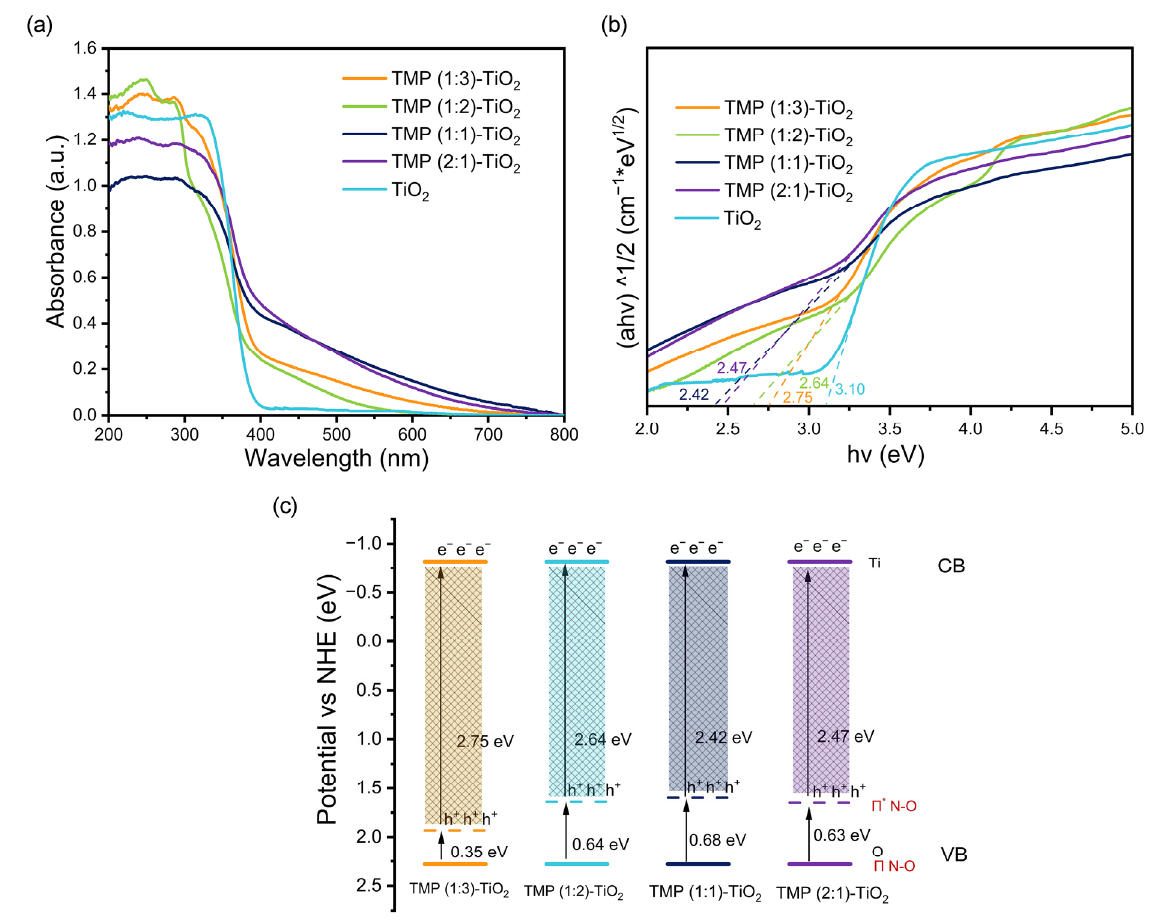
Figure 5. ( a ) UV-Vis DRS of the TMP–TiO 2 . ( b ) Diagram of the Kubelka–Munk function of the TMP–TiO 2 versus the absorbed light energy (band gap width). ( c ) Location of TMP–TiO 2 conduction band (CB) and valence band (VB).